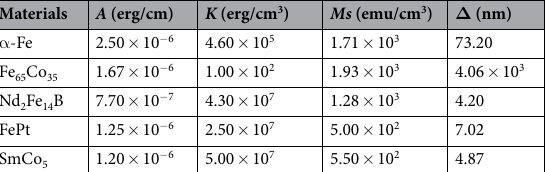
Table 1. Intrinsic magnetic properties for various magnetic materials. A , K , Ms and Δ denote the exchange constant, the volume anisotropy constant, the spontaneous magnetization and the Bloch wall width